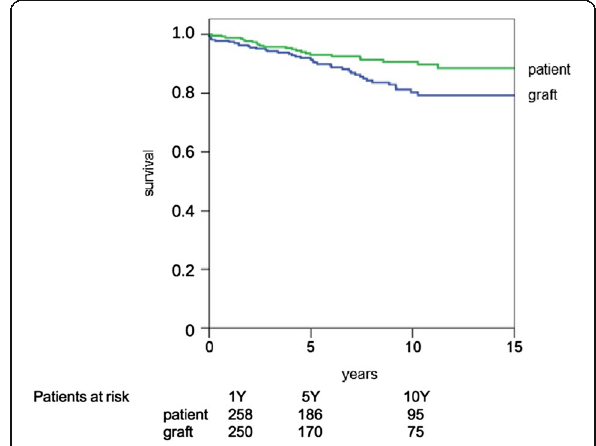
Fig. 3 Patient- and graft survival after living donor kidney transplantation (LDKT). Patient- and graft-survival rates at 1, 5, and 10 years after transplantation were 98.9, 92, and 88.7% and 97.4, 91.6, and 80.6%, respectively